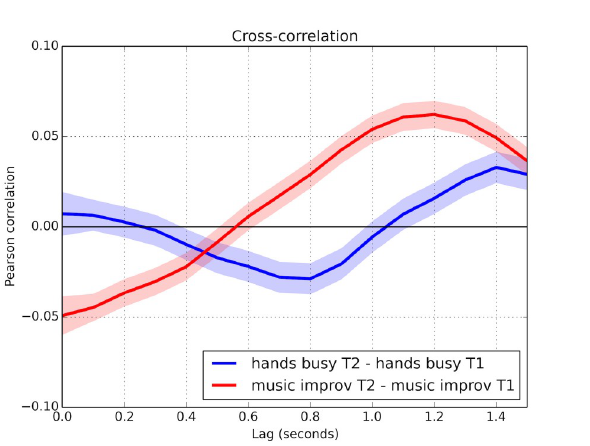
Fig 2. Cross-correlation curves showing the subtraction of the post-activity coordination (T2 correlations) from the pre-activity coordination (T1 correlations) for both groups. Shading represents Bonferroni-corrected 99.99% confidence intervals. A statistically significant difference of p < 0.0001 is implied when shaded areas of two curves do not touch or overlap at a given time.